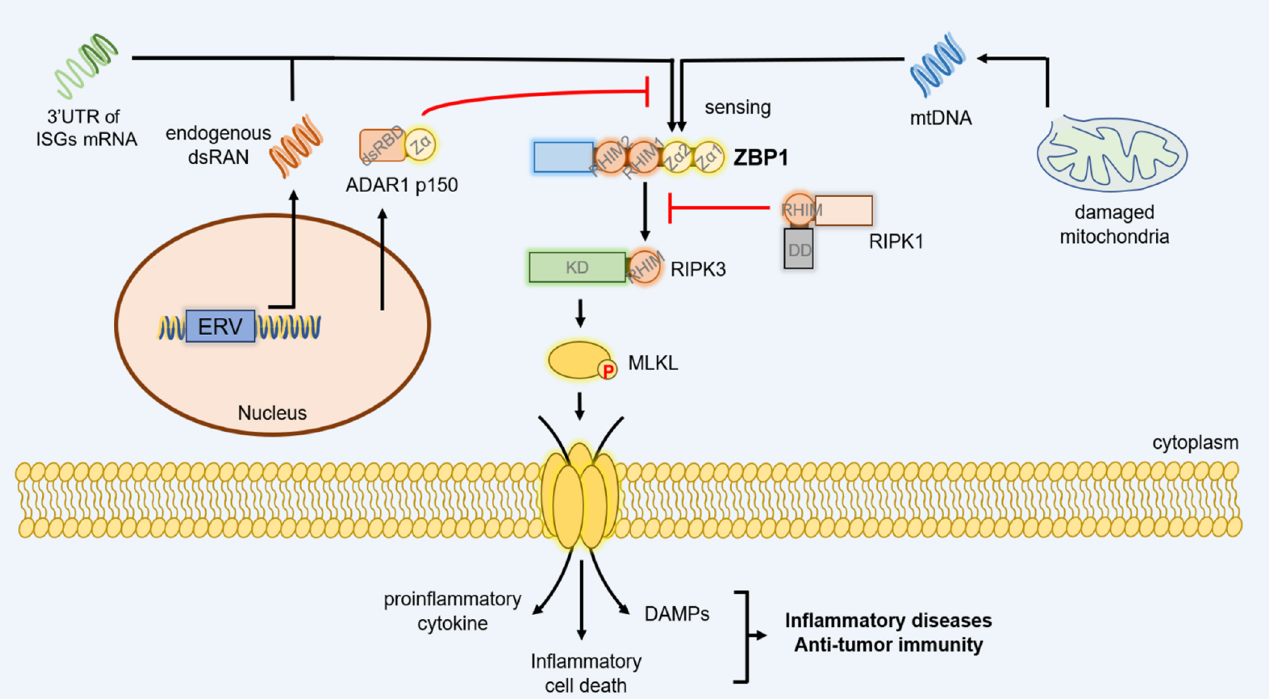
Figure 4. The model for endogenous ZBP1 activation and the host antagonistic mechanisms targeting ZBP1 signaling. The endogenous retroviruses (ERV)-derived dsRNA, released cytoplasmic mitochondria DNA (mtDNA), and Z-RNA enriched in 3’UTR of ISGs mRNA that harbor inverted SINEs or GU-type simple repeats act as the activated ligands of ZBP1 and induce endogenous ZBP1 signaling. The endogenous activation of ZBP1 causes many auto-inflammatory diseases or stimulates tumor immunity. ADAR1-p150 inhibits the ligands sensing of ZBP1 by the Z α domain and RIPK1 blocks the signaling transduction of ZBP1 by its RHIM.